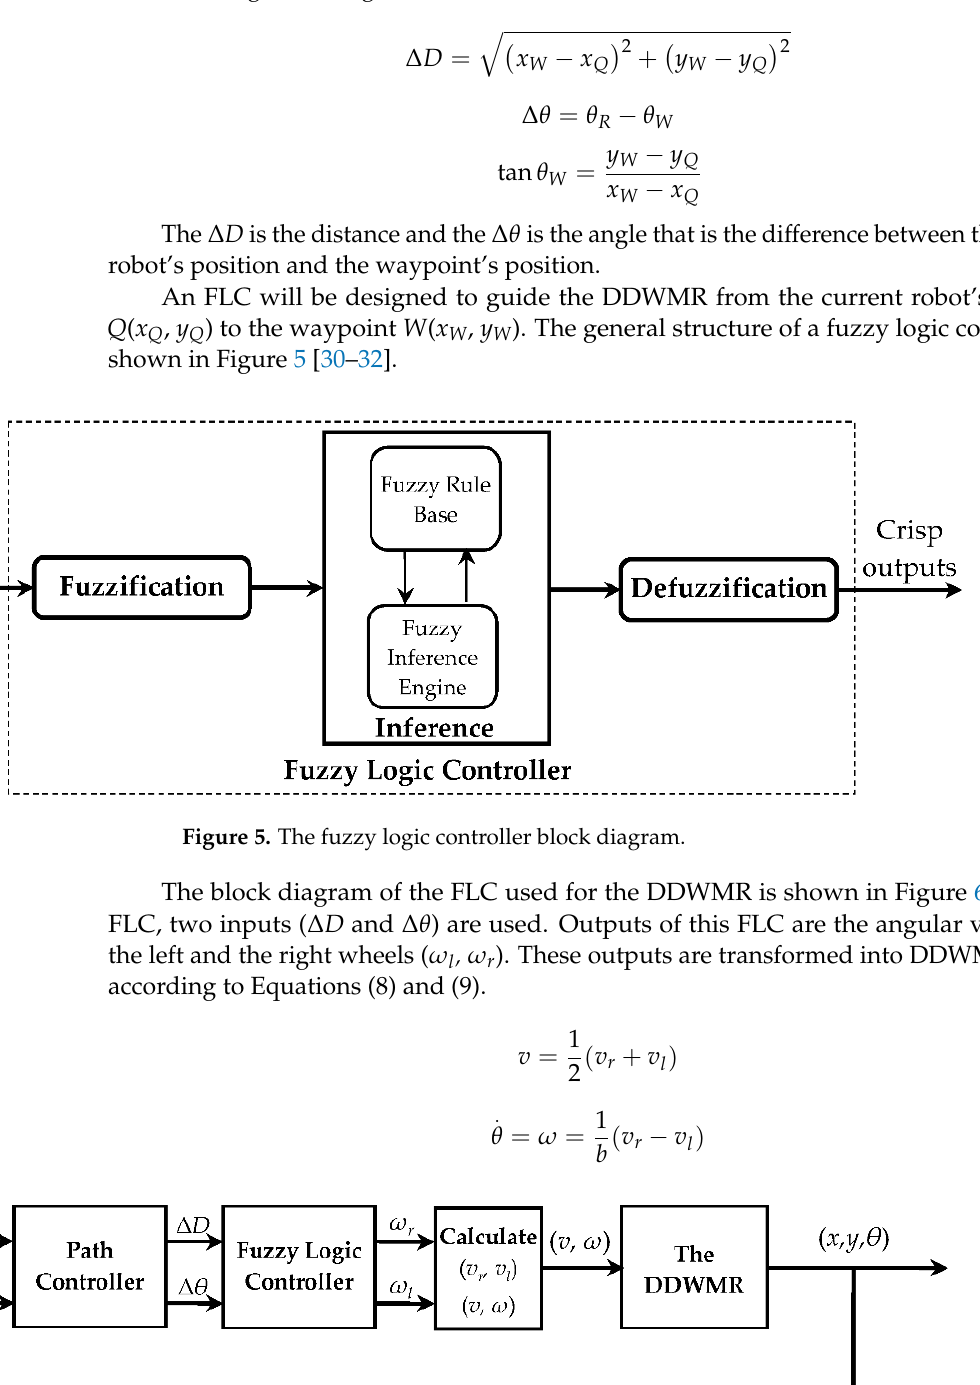
Figure 6. The block diagram of the fuzzy logic controller used for the differential drive wheeled mobile robot.